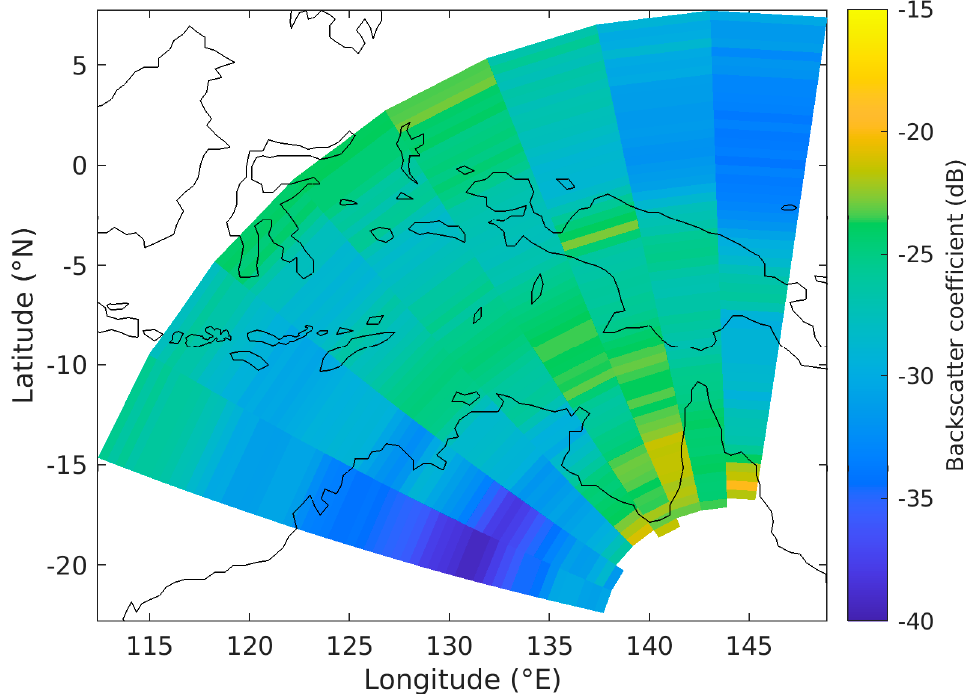
Figure 3. Map of the monthly mean backscatter coefficients for LO in January 2015.